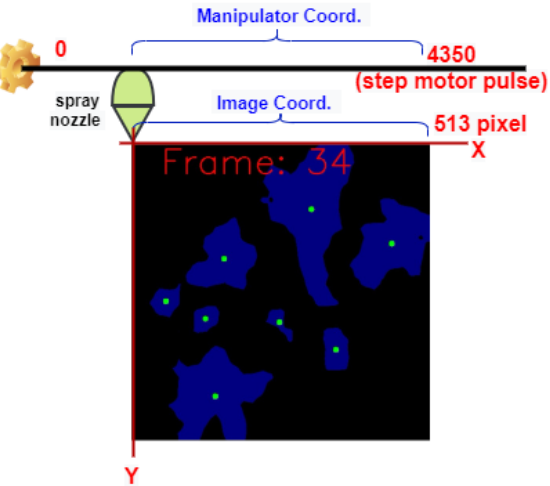
Figure 9. Image coordinate and Cartesian robot coordinate.